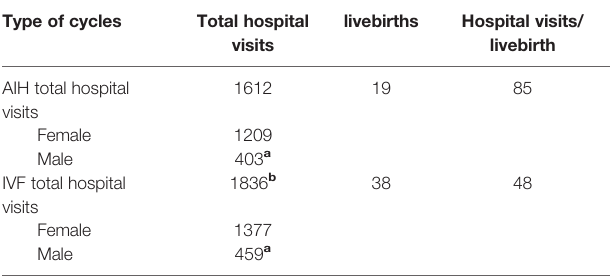
TABLE 6 | No. of hospital visits for IVF and IUI groups.